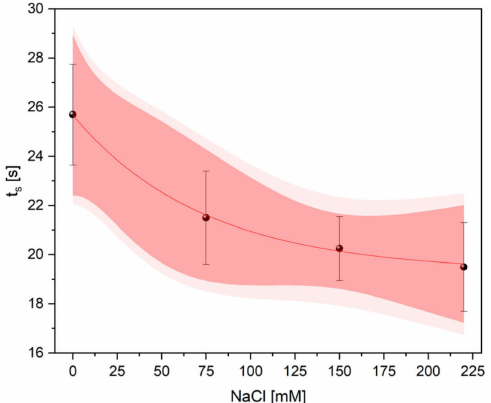
Figure 6. An exponential decay of thermal time constant estimated for control and salt-treated plants as a result of an acute HL treatment. Data are shown along with 95% prediction ( light red surfaces ) and confidence ( dark red surfaces )